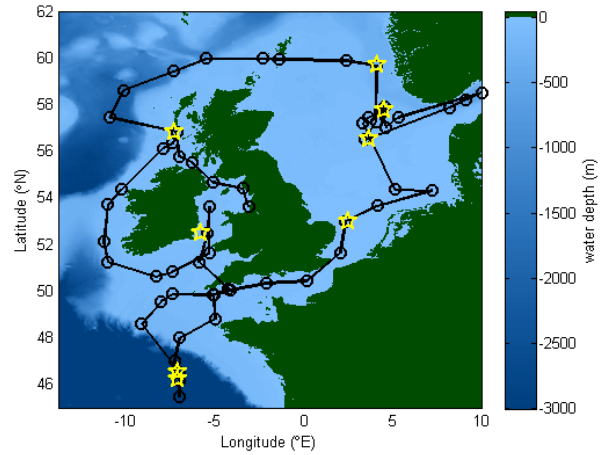
Figure 1. Cruise track superimposed on a map of the bathymetry of the study area (from the ETOPO5 data set). Locations of CTD stations are shown with black circles. Locations of eight bioassay experiments are shown with yellow